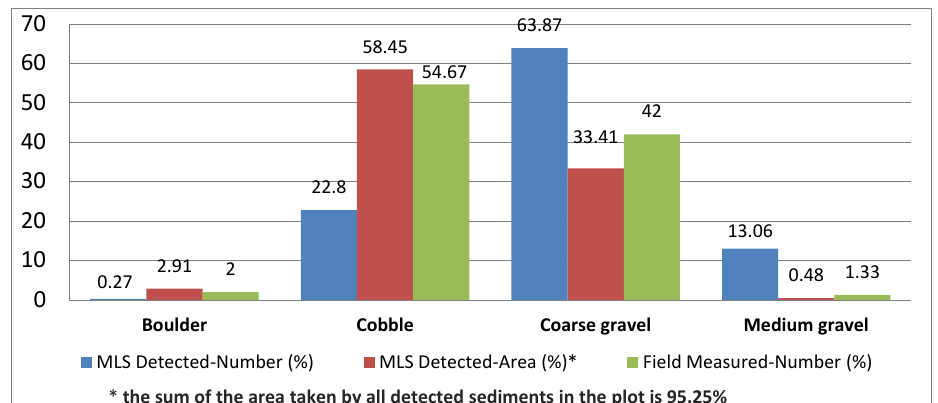
Figure 10. Comparison of grain size distribution in the test plot based on the single-track MLS data and based on the field measurement. The first column for each sediment class (blue) represents the distribution according to the population rate measured from MLS data; the second column (red) represents the distribution according to the areal coverage measured from MLS data; the third column (green) represents the distribution according to the population rate measured in the